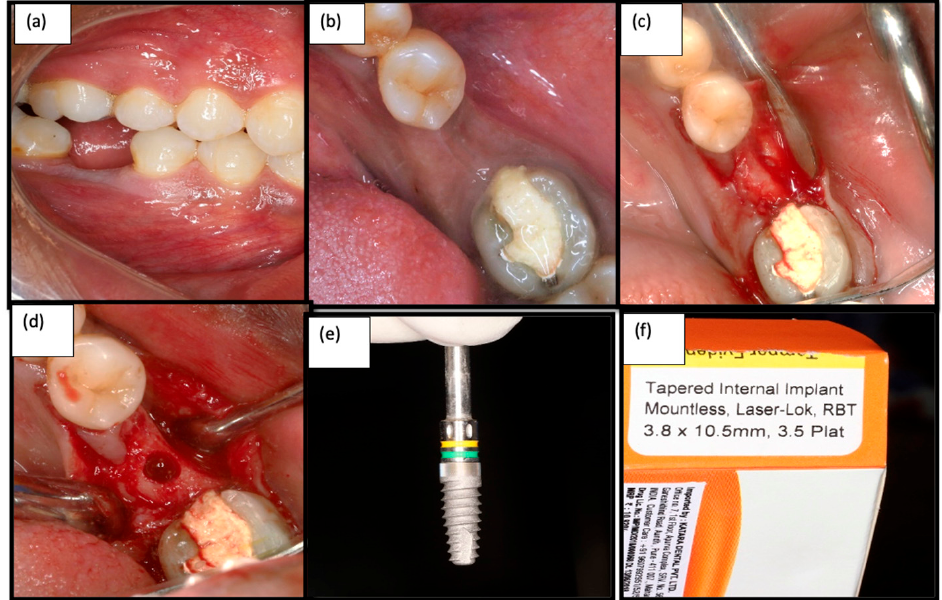
Figure 2. ( a ) Isolated edentulous site—Buccal view; ( b ) : Intra oral photograph of the edentulous site—Occlusal view ( c ) : Crestal incision given and flap elevation performed ( d ) final osteotomy site preparation done for 3.8 mm; ( e , f ) Laser micro-grooved Implants (Laser lok ®